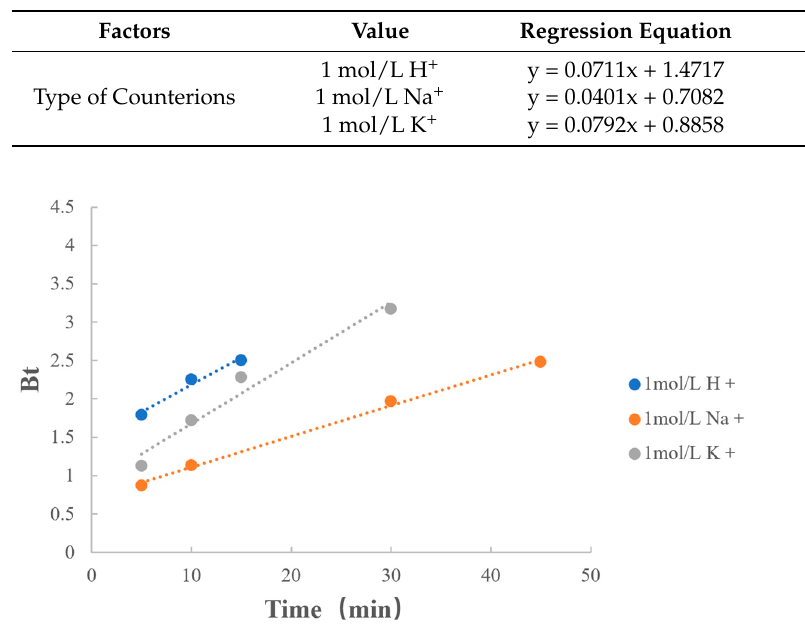
Figure 9. Boyd model fitting on type of counterions.